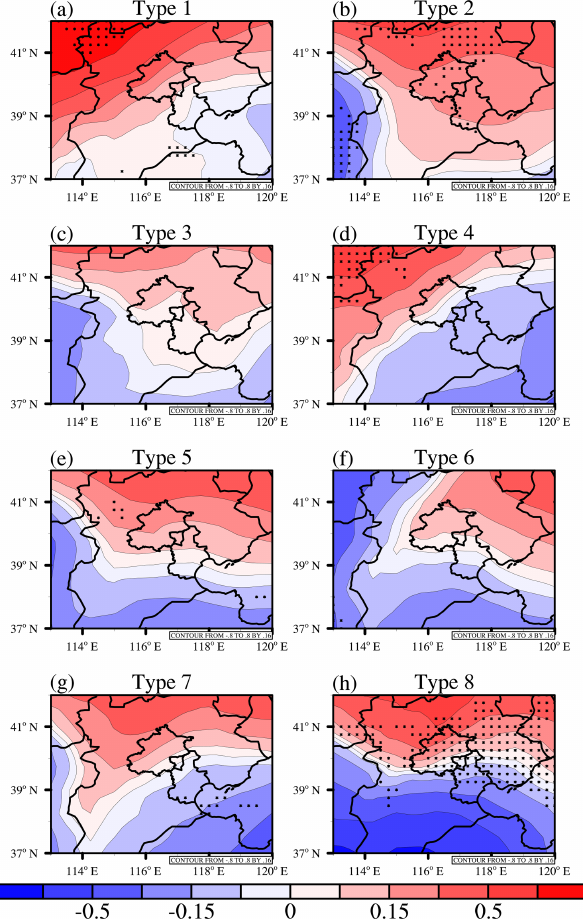
Figure 6. Changes in SLP over the JJJ region under eight circulation types in the CP El Niño years relative to the climatological means (unit: hPa). The dots indicate that the differences between more than 60% of ensemble member pairs have the same sign as the mean